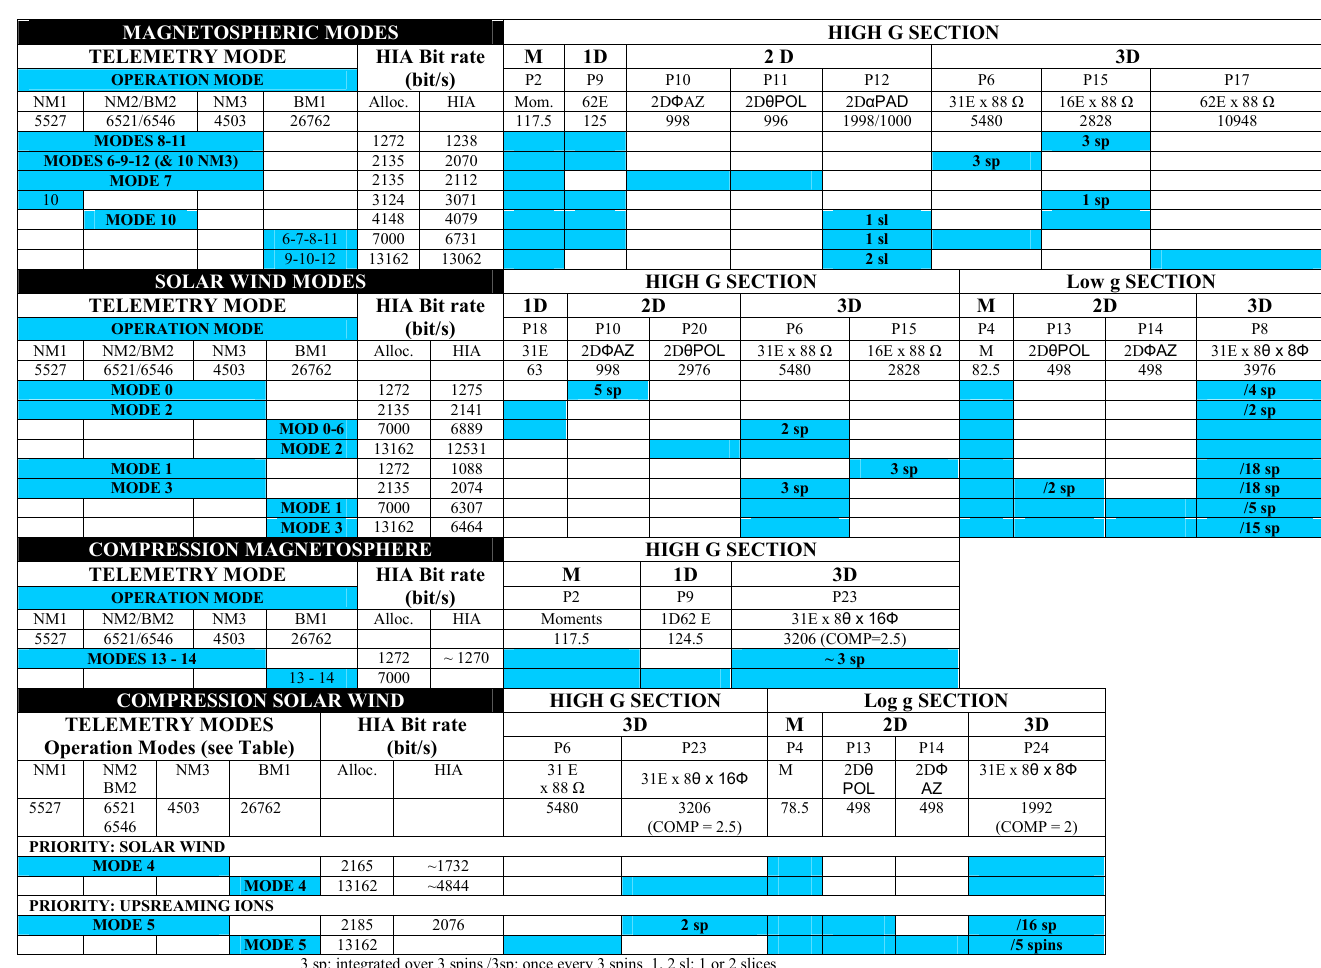
CIS2: SCIENTIFIC MODES